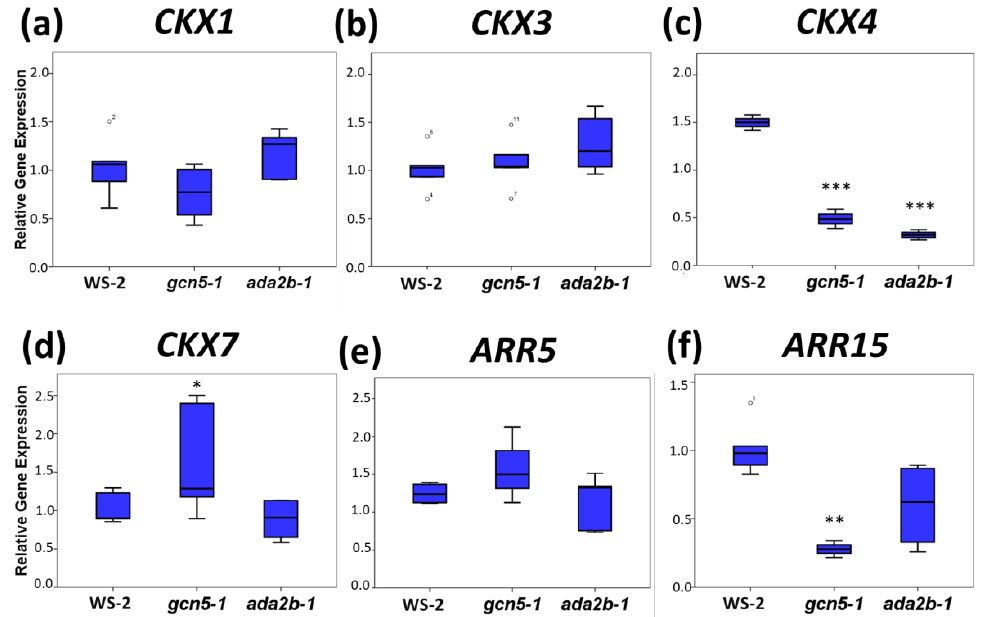
Figure 4. The role of GCN5 and ADA2b in cytokinin catabolism and signaling-related gene expression in Arabidopsis thaliana roots. The analysis was carried out in roots of seven-day-old Ws-2, gcn5-1 , and ada2b-1 plants using qRT-PCR for the genes ( a ) CKX1 , ( b ) CKX3, ( c ) CKX4 , ( d ) CKX7 , ( e ) ARR5 , and ( f ) ARR15 . The bars represent the range of the two quadrants, the horizontal line in the bar the median, while the terminals are the minimum and maximum values of the data. Asterisks indicate the statistical significance based on an independent samples t -test: * p < 0.05, ** p < 0.01, and *** p < 0.001.